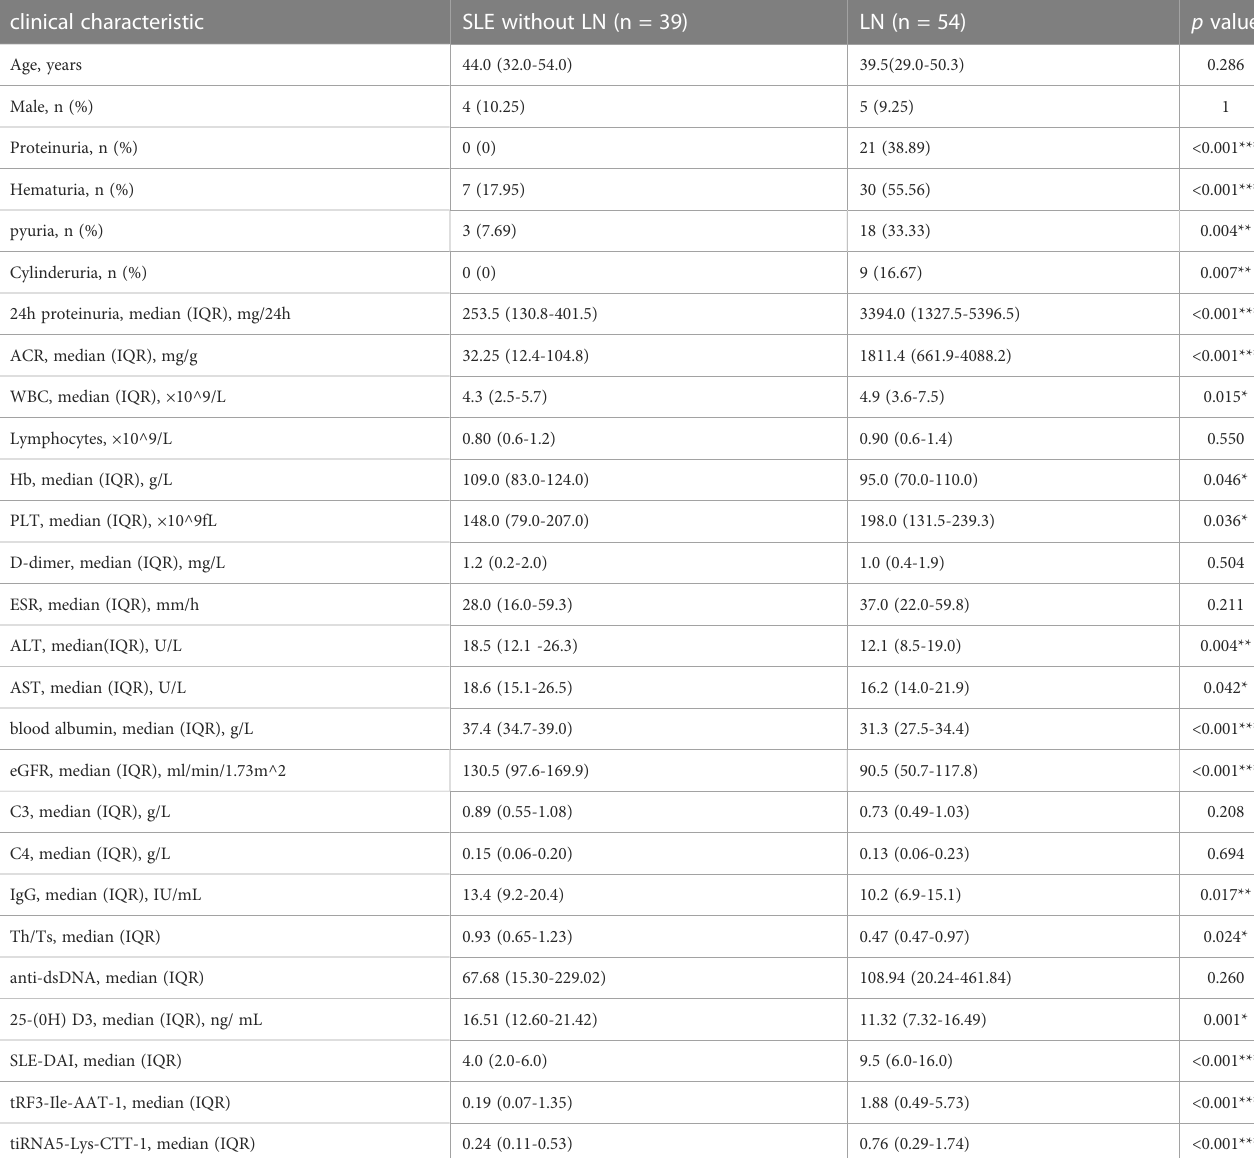
TABLE 1 Statistics of clinical information of validation phase specimens. clinical